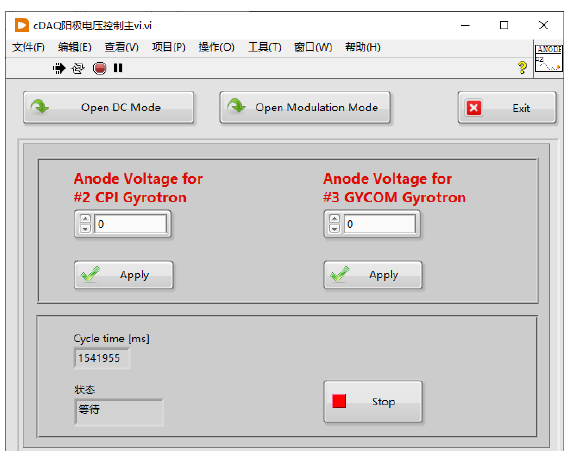
Fig. 5. The host computer control interface (DC mode) of ASIPP anode power supply.